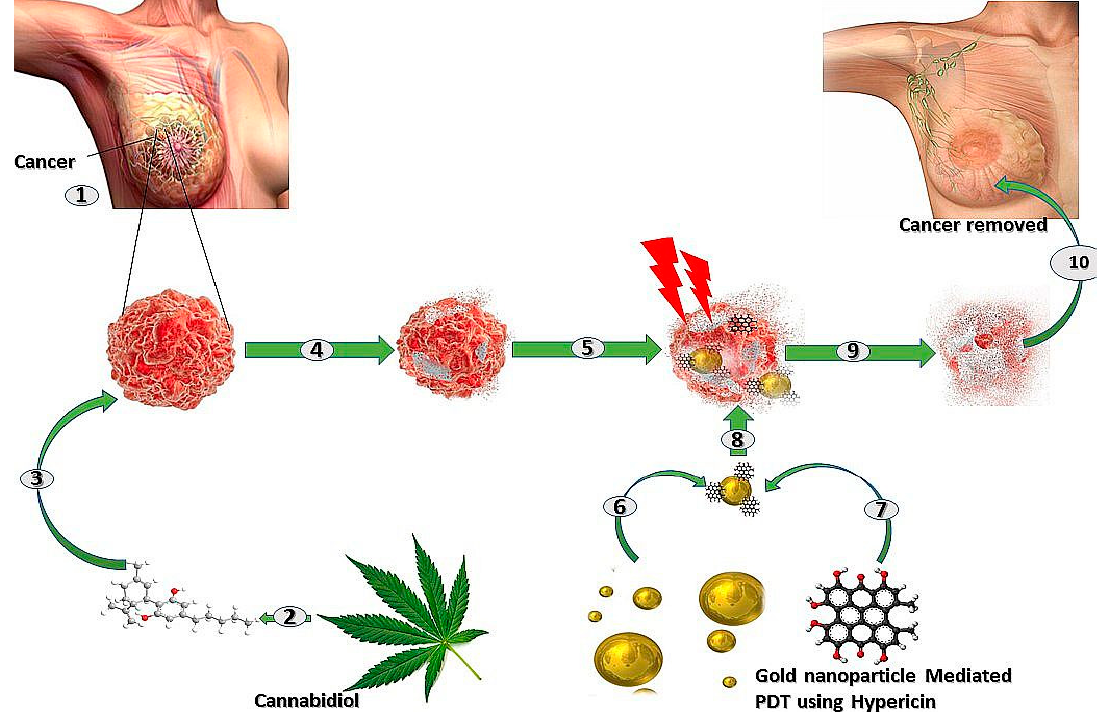
Figure 3. Combination therapy using cannabidiol and PDT to effectively treat breast cancer. (1) A lump of tumour in the right breast of a female. (2) Cannabis leaf can be used to extract Cannabidiol, (3) which, when injected in the body, binds to the Cannabidiol receptors on the tumour cells, (4) inducing cell death via activation of apoptosis. (5) Cells of the tumour start dying but Cannabidiol treatment alone is not efficient. (6) AuNPs and (7) Hypericin can be conjugated to form (8) a AuNP-Hypericin PS, which, when used in the PDT of the Cannabidiol treated tumour cells by exposure to light at a wavelength of 594 nm, (9) induces cytotoxicity of the cancer cells further enhancing cell death. (10) Ultimately, with combined therapy, there is maximum eradication of the tumour, restoring normal breast tissue.